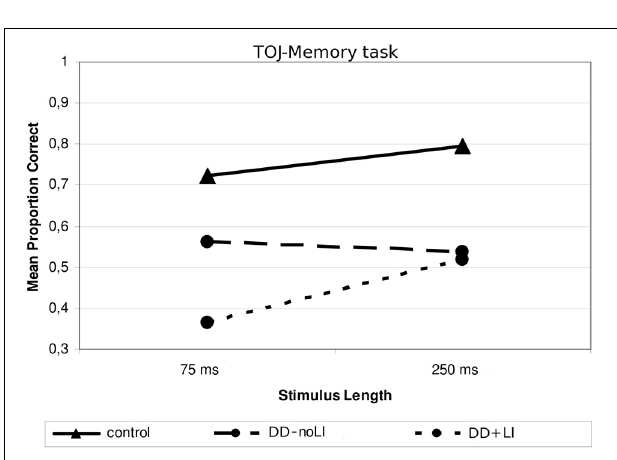
among subgroups could explain part of the heterogeneity of results described in the literature concerning